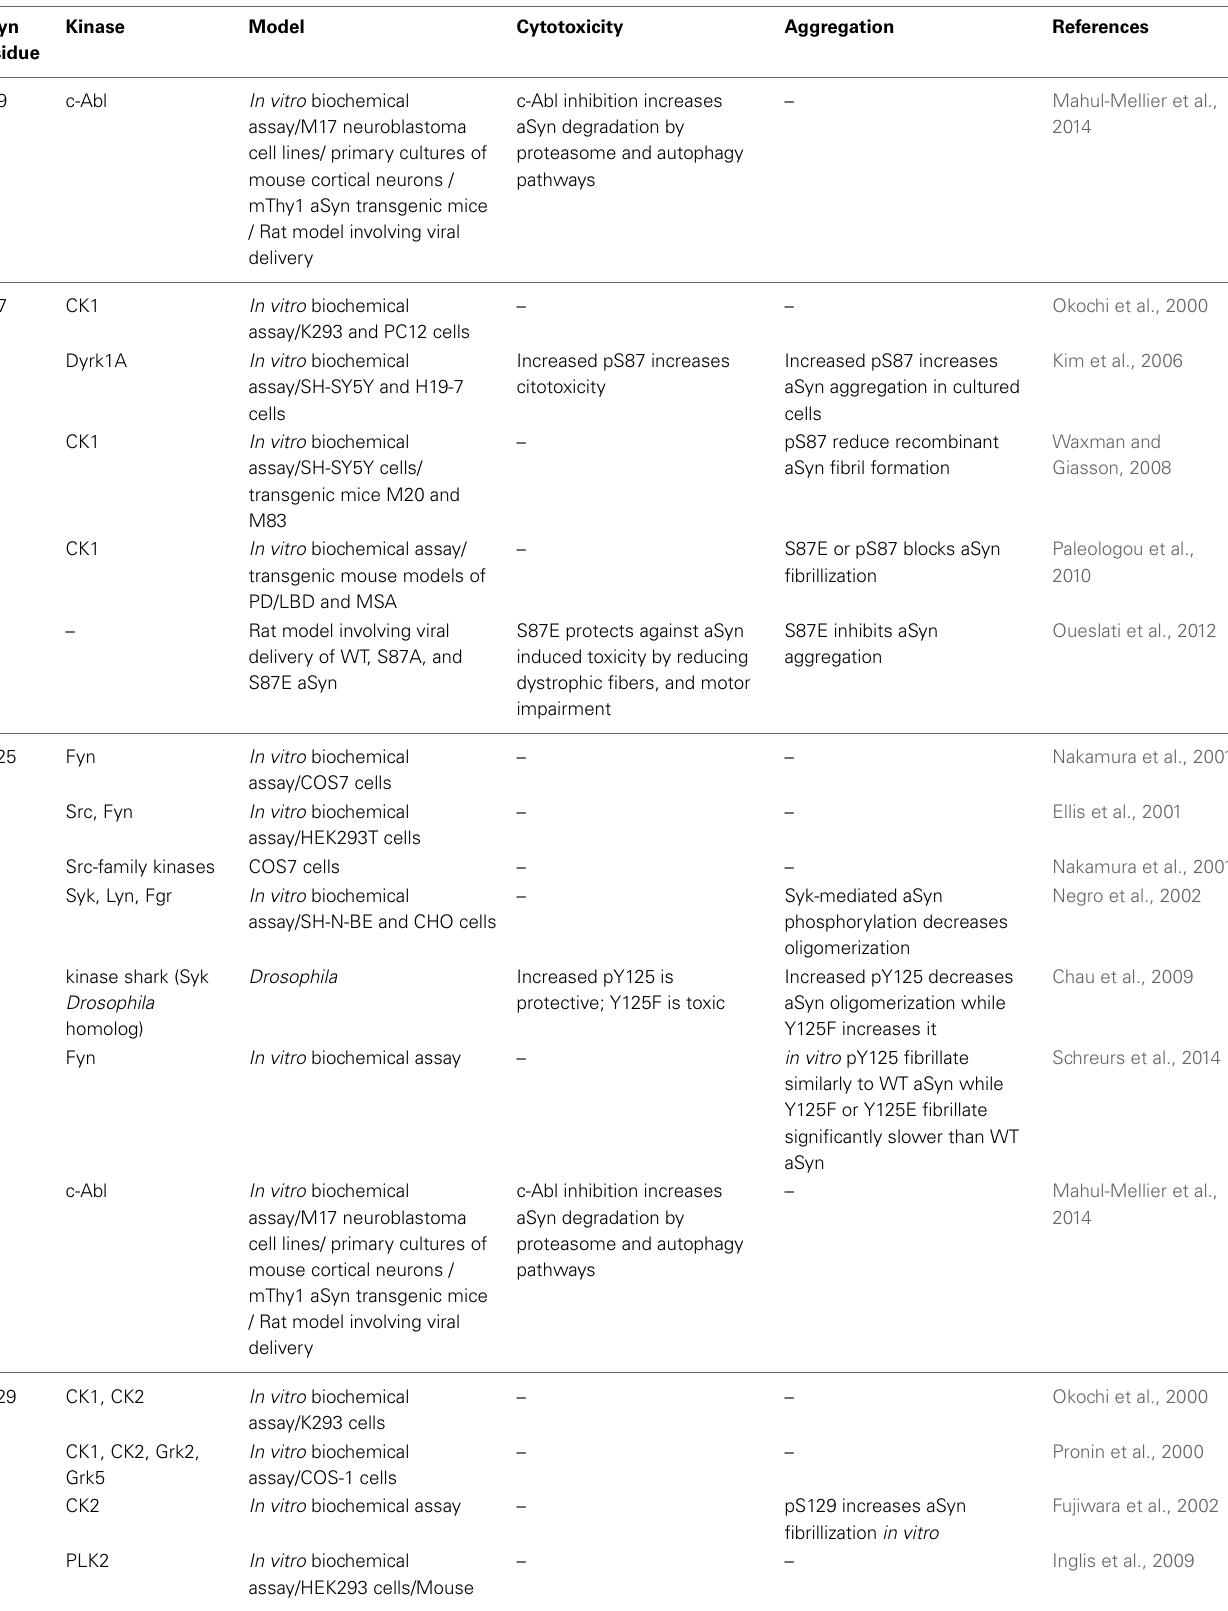
Table 1 | aSyn phosphorylation sites and effects.